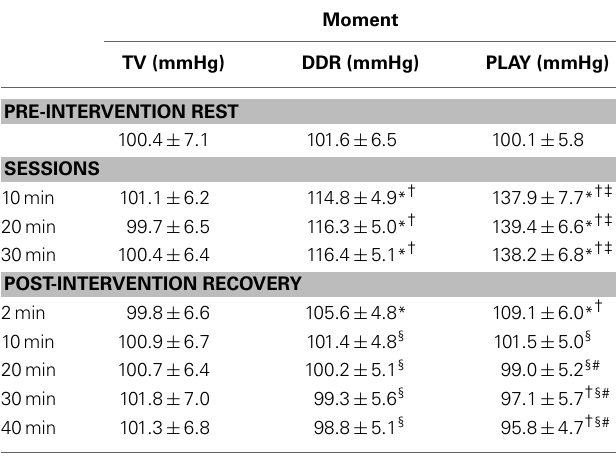
Table 2 | Systolic blood pressure mean values ( ± SD ) of all sessions (TV, DDR, and PLAY) ( n = 18).